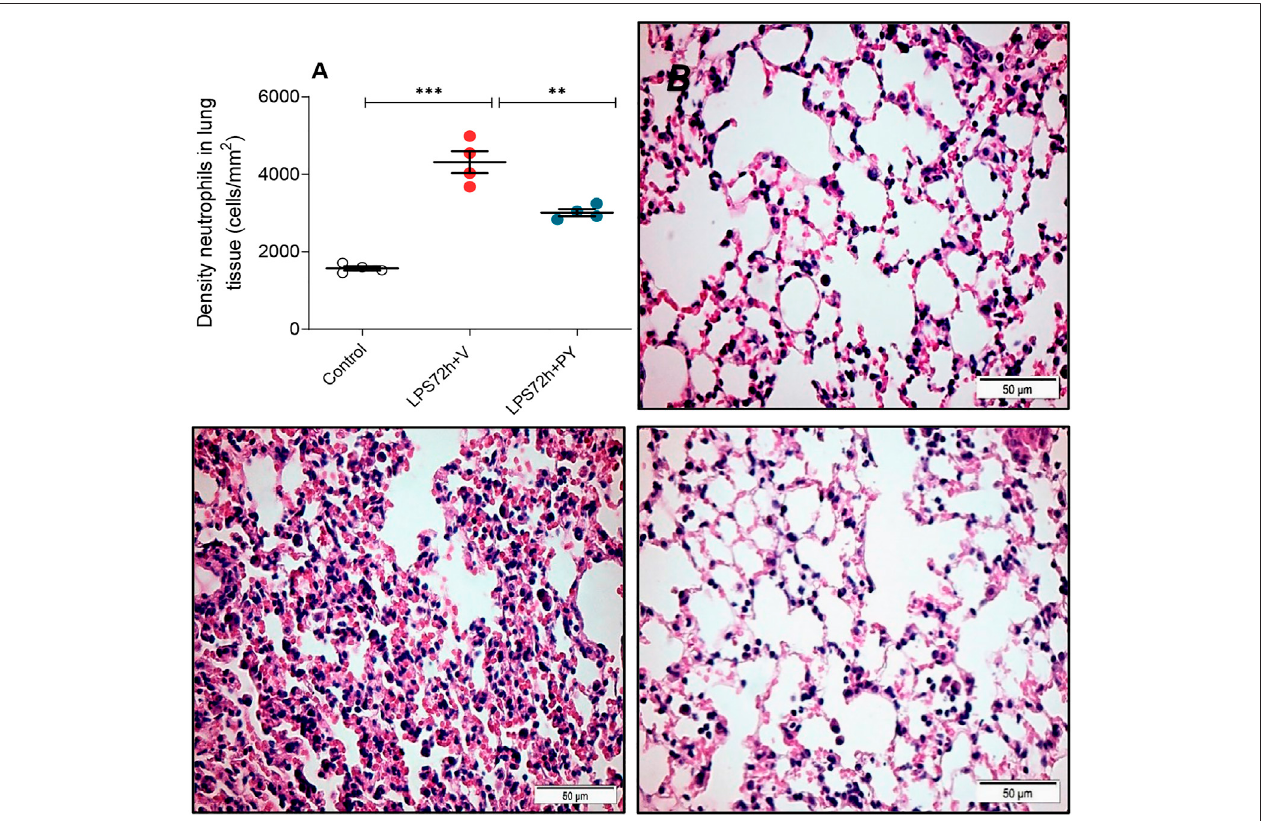
FIGURE3| PyridostigminedecreasesthedensityofneutrophilsinlungtissueofLPSexposedmiceat72 h. (A) Quanti fi cationofneutrophils*** p < 0.00,** p < 0.01. (B, C, D) Representative photomicrographs of lung tissues stained with hematoxylin-eosin (B) control (C) LPS + vehicle (D) LPS + pyridostigmine. Magni fi cation, × 400. Values expressed as mean ± SEM. One-way ANOVA followed by Tukey ’ s test (See text for details).